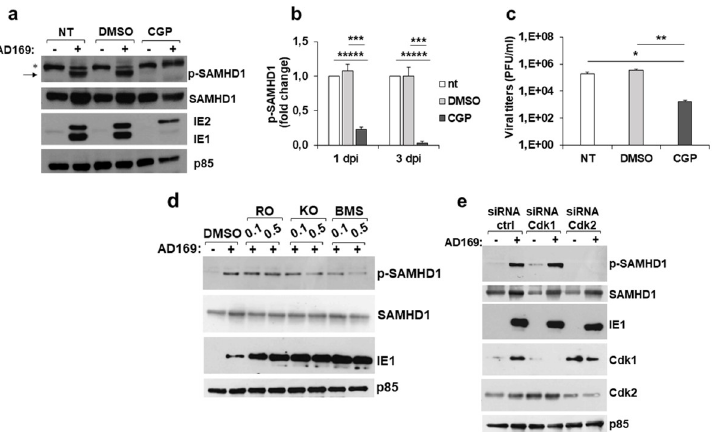
Fig 6. Inhibition of Cdk2 abrogates T592 phosphorylation. a) HFFs were pretreated for 5 h with the Cdk1 inhibitor CGP74514A (CGP), and then not infected or infected with AD169, in the presence of CGP. After removing virus inoculum, the inhibitor was newly added and kept until cell harvesting, at 3 dpi. Total or pT592-SAMHD1 levels were analyzed by immunoblotting, together with IE1/IE2 and p85 expression. A representative experiment out of five is shown. b) The relative amount of pT592-SAMHD1, normalized to that of p85, was determined by densitometric analysis and is relative to that of n.i. cells, which was arbitrarily set as 1. Data are expressed as mean ± SE of four independent experiments performed at 1 and 3 dpi. c) Effect of CGP on infectious virus production as measured by standard plaque assays on cell culture supernatants at 3 dpi. Results derive from seven experiments and are expressed as mean ± SE. d) HFFs were pretreated as in panel a) with the Cdk inhibitors RO-3306 (RO), KO-3861 (KO) or BMS- 265246 (BMS) at the indicated concentrations ( μ M), and then not infected or infected with AD169, in the presence of the inhibitors. After removing virus inoculum, the drugs were newly added and kept until cell harvesting, at 1 dpi. Immunoblotting was performed as above. One representative experiment out of two is shown. e) HFFs were transfected with Cdk1 or Cdk2 siRNA or non-targeting siRNA (ctrl). The day after, cells were not infected or infected with AD169 at an MOI of 1 and harvested at 1 dpi. Immunoblotting was performed as above. One representative experiment out of two is shown. NT, not treated cells; DMSO, cells treated with the vehicle DMSO; � , unspecific band; black arrow, pT592-SAMHD1 specific band. � , p < 0.05; �� , p < 0.01; ��� , p < 0.001; ���� , p < 0.0001; ����� , p <